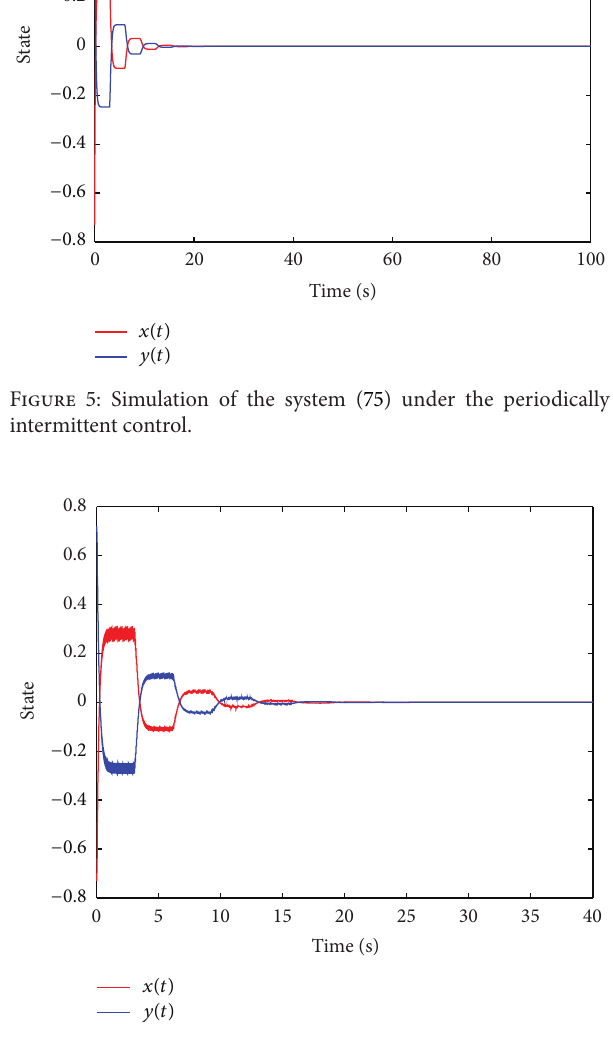
Figure 4: Simulation of the system (75) under the continuous feedback control.